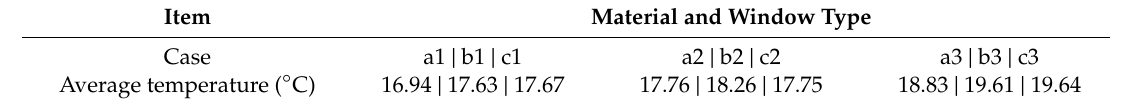
Figure 13. Average temperature distribution of the CFD simulation. Table 9. Winter simulation results.